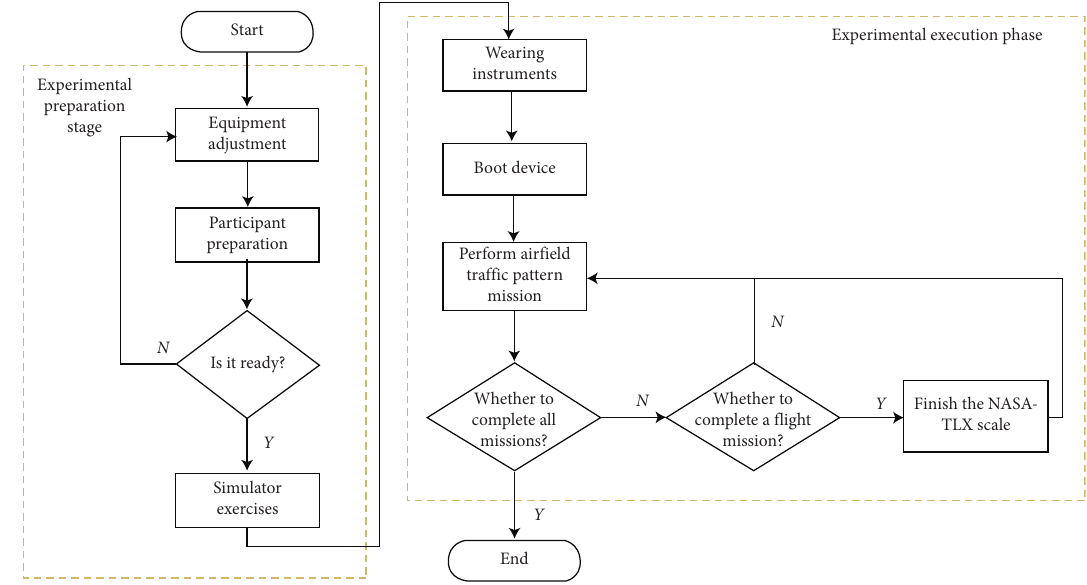
Figure 6: Experimental flow